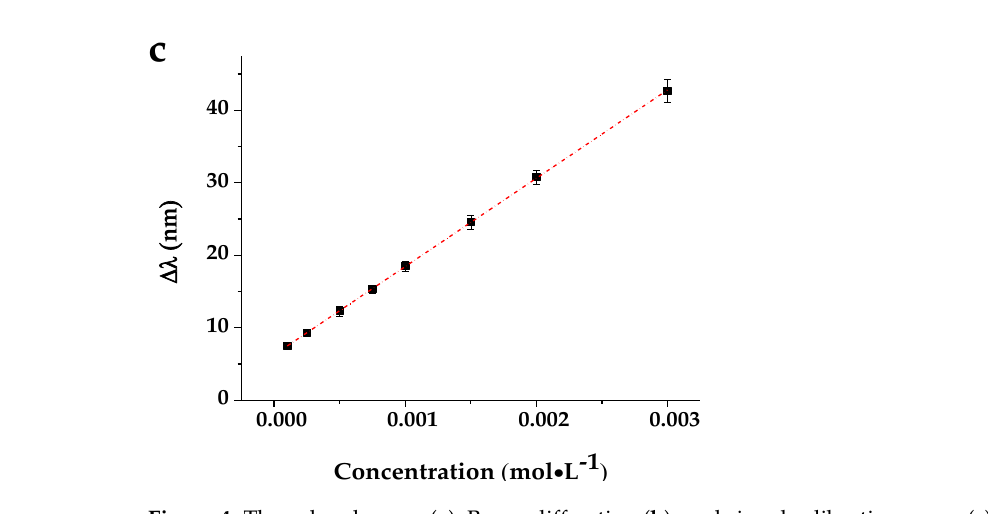
Figure 4. The color changes ( a ), Bragg diffraction ( b ), and signal calibration curve ( c ) of MIPC film upon response to BPs.